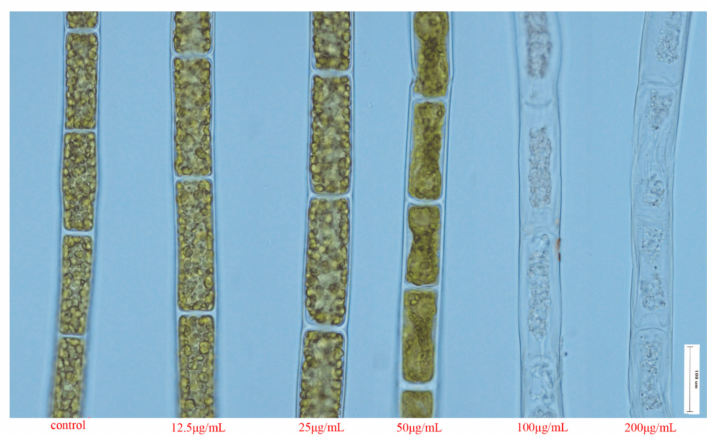
Figure 3. E ff ect of the essential oil of T. flousiana on the morphology of S. communis . S. communis was treated with the essential oil at di ff erent concentrations for 96 h, the morphological changes were imaged with microscope (Nikon Eclipse Ti) at a magnification of 10 × .